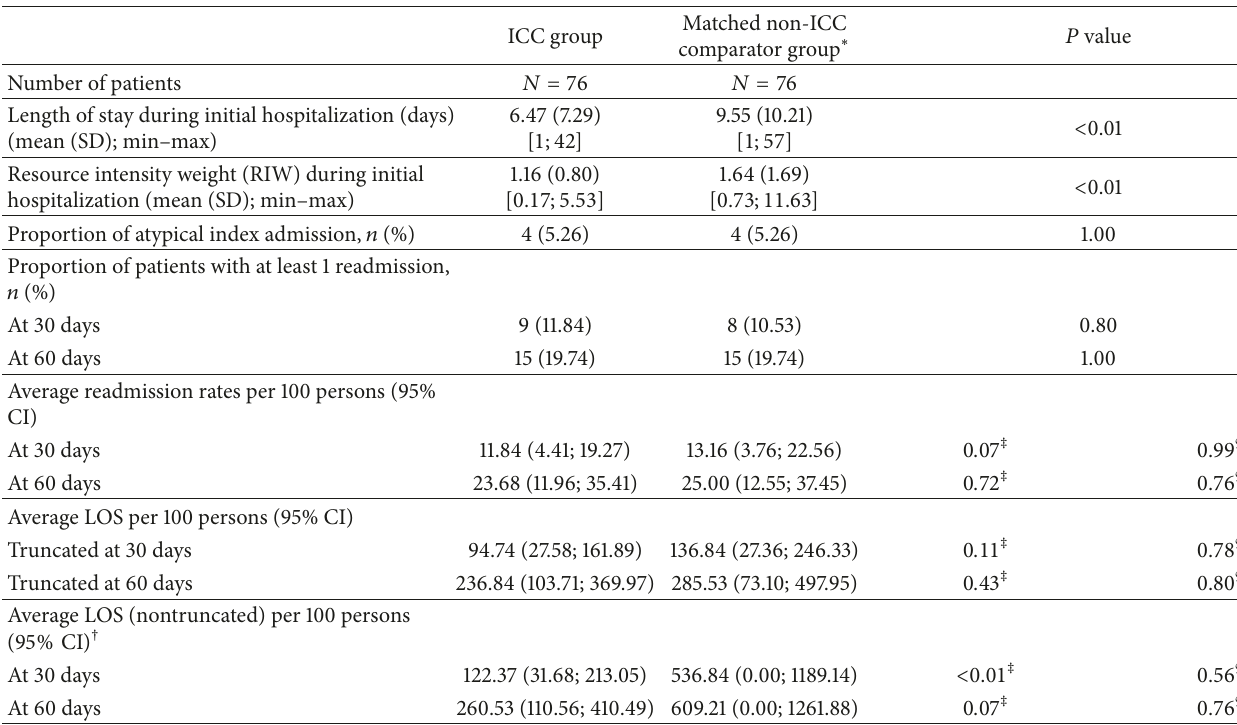
Table 3: Medical resource utilization within the index admission and up to 60-day follow-up within the matched population. ICC